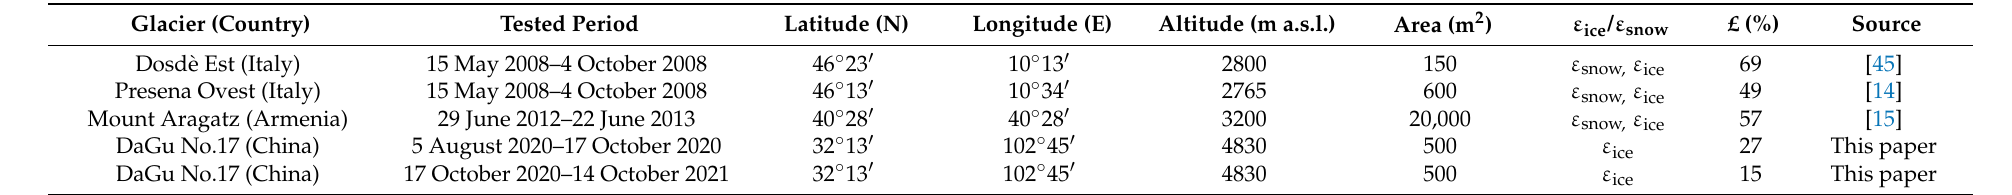
Table 3. Studies documenting the local melt reduction by geotextiles. £ refers to the percentage reduction in melting compared to an uncovered location. ε snow refers to the presence of snow under the cover. ε ice refers to the fact that there is only ice under the cover. Glacier